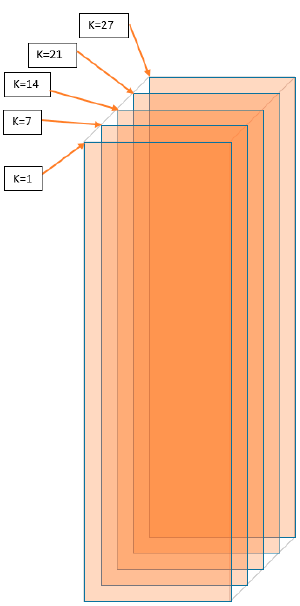
Figure 10. Cross-sectional planes, 3 cm apart, where results are presented.